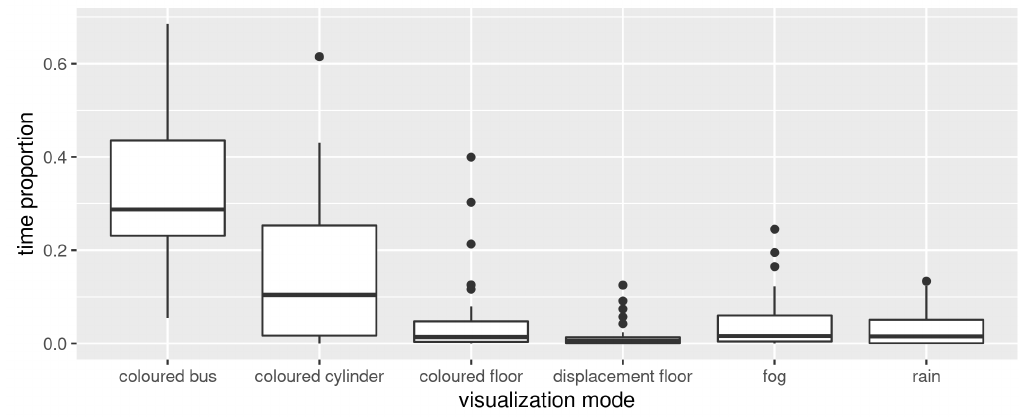
Figure 14. Box plot of proportion of time spent by participants in each pollution visualisation representation, while performing the four first tasks.